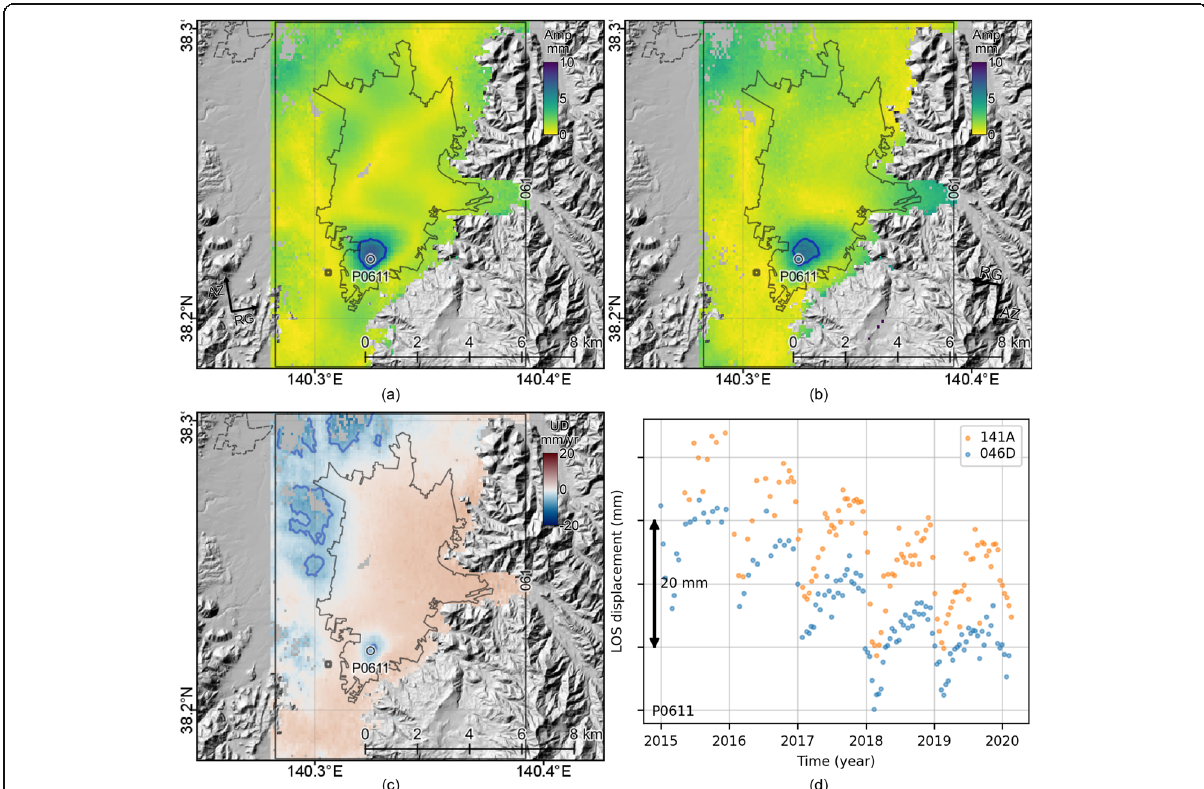
Fig. 6 a Amplitudes of the annual LOS fluctuation in Yamagata (ID: 061) from the ascending 141A_05118_131311. The black lines denote the outlines of the DID. The interval of the contour lines is 5 mm. The black square denotes the reference point. b Amplitudes from the descending 046D_05096_121313. c Vertical deformation velocities. The interval of the blue (subsidence) contour lines is 5 mm/year without the 0 mm/year lines. d LOS deformation time series at P0611 for each